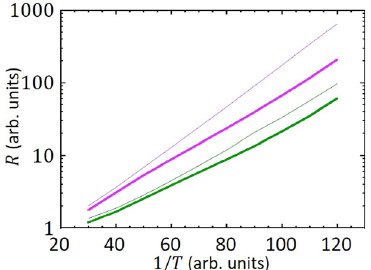
Fig. 4 Numerical results. Resistance as a function of inverse temperature with (green curves) and without (magenta curves) long-range interactions. Thick lines correspond to the case without site disorder, while thin lines to disordered